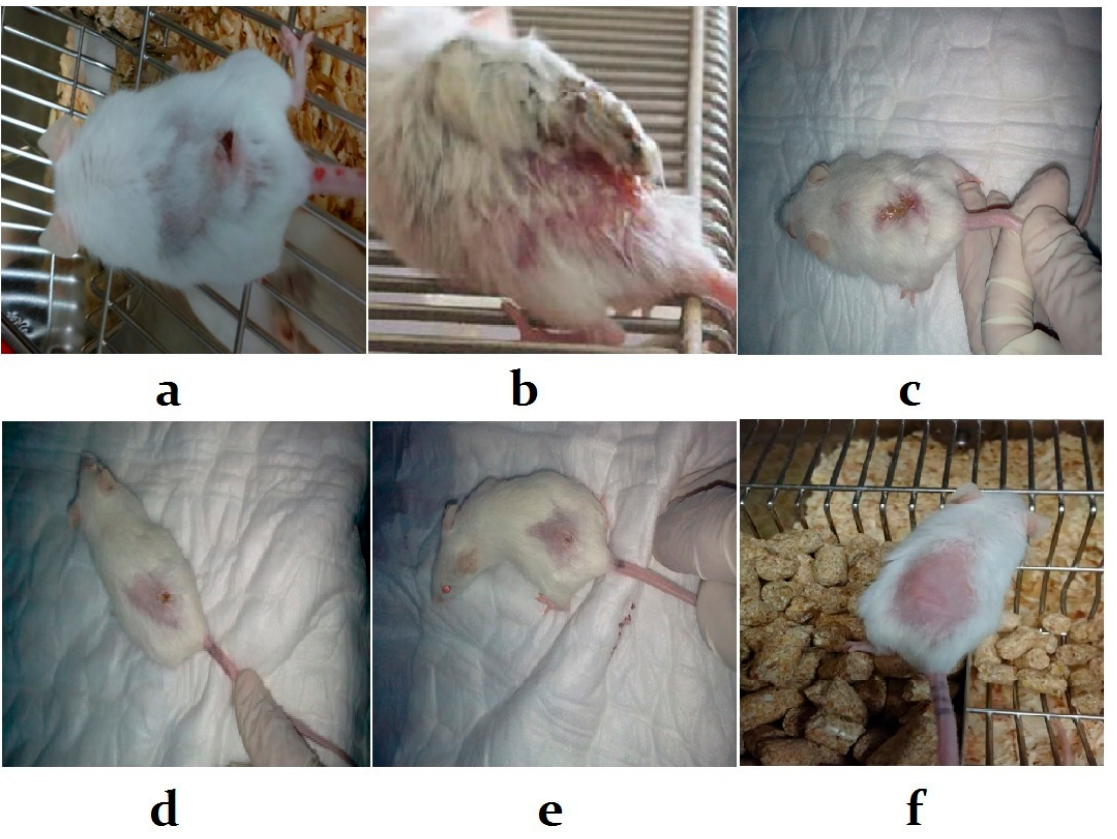
Figure 2. Cutaneous lesions of infected mice in with or without of pomegranate juice supplementation. ( a ) Three weeks of post-infection untreated mouse showing redness, swelling and ulcer formation. ( b ) Seven weeks post-infection untreated mouse showing redness, swelling, ulcer and gangrene formation. ( c ) Three weeks post-infection treated with Pentostam showing redness, swelling, ulcer and gangrene formation, however, the formed lesion was smaller than that of untreated mice. ( d ) Three weeks post-infection treated with pomegranate showing restored to normal skin with small ulcer. ( e ) Three weeks post-infection treated with pomegranate and CIP showing restored to normal skin with small ulcer. ( f ) Four weeks post-infection pretreated with pomegranate showing restored to normal skin.